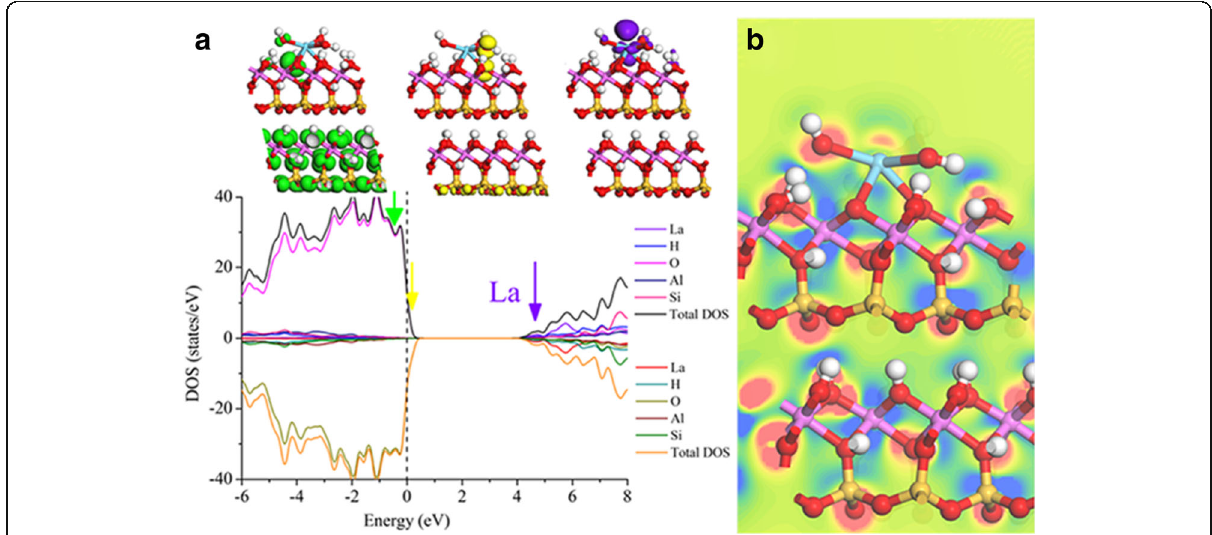
Fig. 8 a The PDOS results of La-HNT surface. b Charge density difference of the La-HNT interface plotted along the plane designated by the dotted lines shown in the lower panel of Fig. 7c. Blue corresponds to charge depletion and red to charge gain. Isosurfaces are shown in the range [ − 0.08, 0.08] (e/Å 3 ). Contours of constant charge density are separated by 0.005 eV/Å